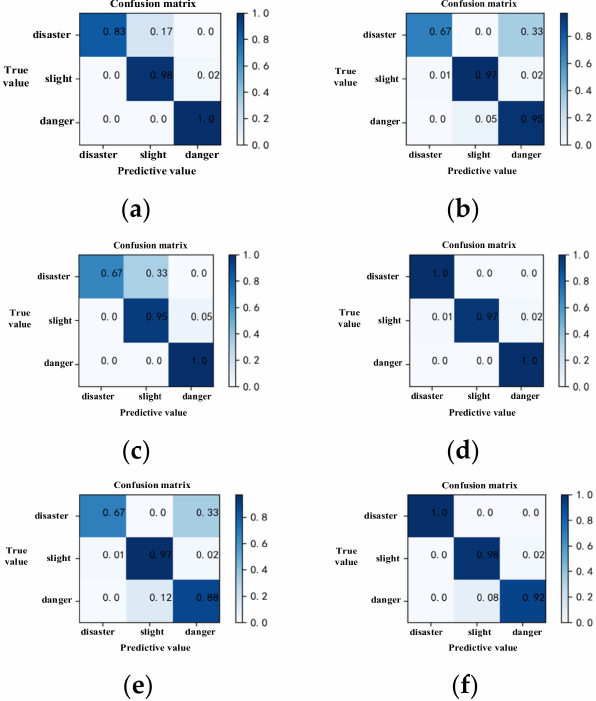
Figure 3. ( a ) Random forest classification experiment results; ( b ) SVM classification experiment results; ( c ) Adaboost classification experiment results; ( d ) naive Bayes classification experiment results; ( e ) KNN classification experiment results; ( f ) logistic regression classification experiment results.